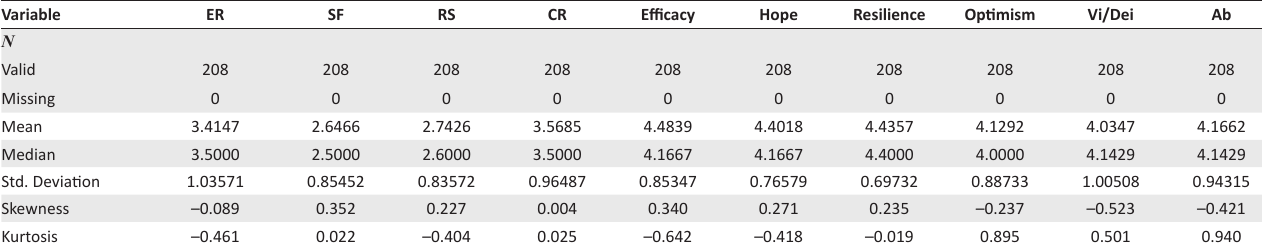
TABLE 2: Mean, median, standard deviation, and skewness and kurtosis. Variable ER SF RS